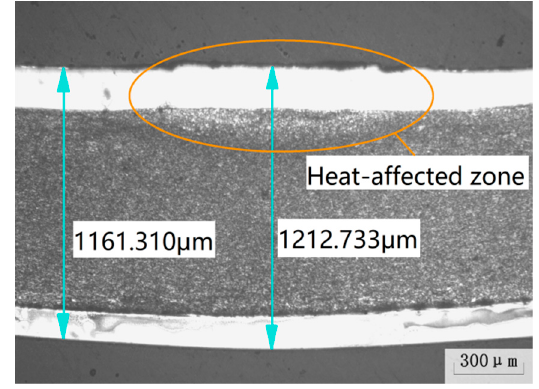
Figure 15. Thickening phenomenon of the SCLP.